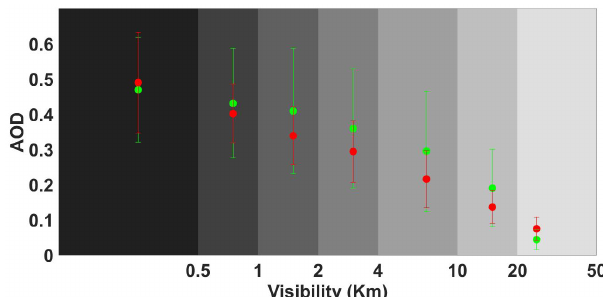
Figure 13. MODIS at 550nm (green) (2000–2014) and AVHRR at 630nm (red) (1981–2009), AOD (June–August) mean values and standard deviations for each visibility index. Shaded areas repre- sent visibility ranges (km) for each visibility class (Table 2). AOD averages have been represented here in the average distance from each